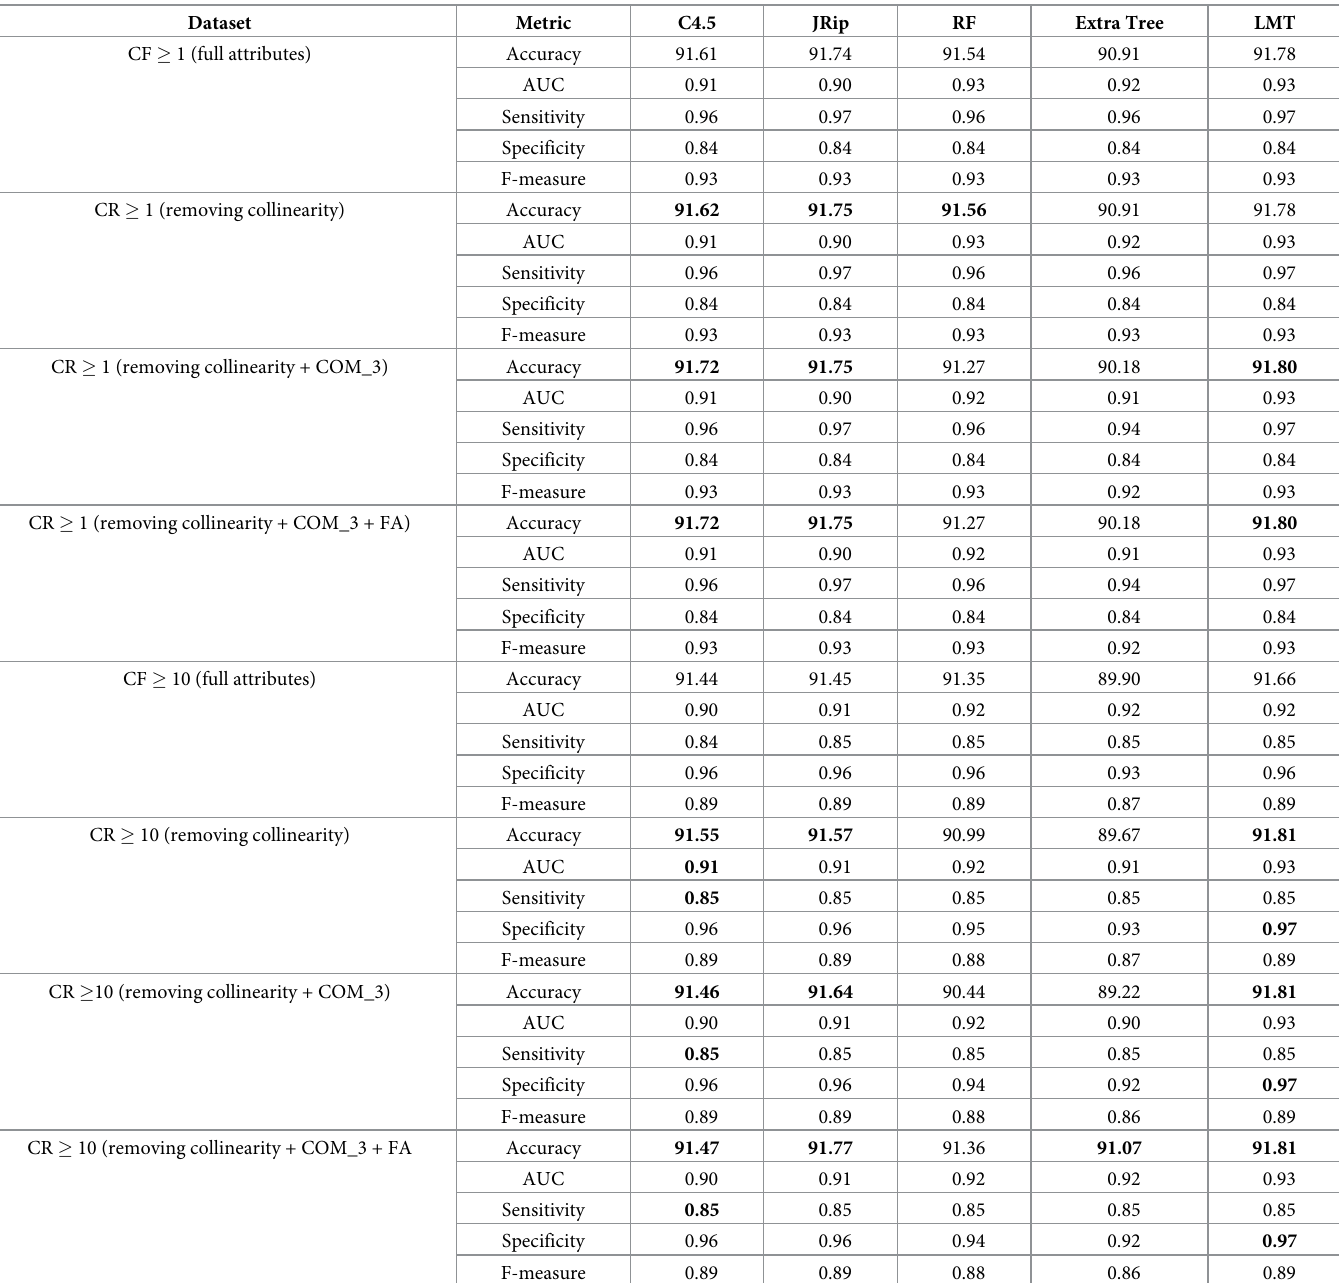
Table 10. Results of three-stage dimension reduction for CF � 1 and CF � 10